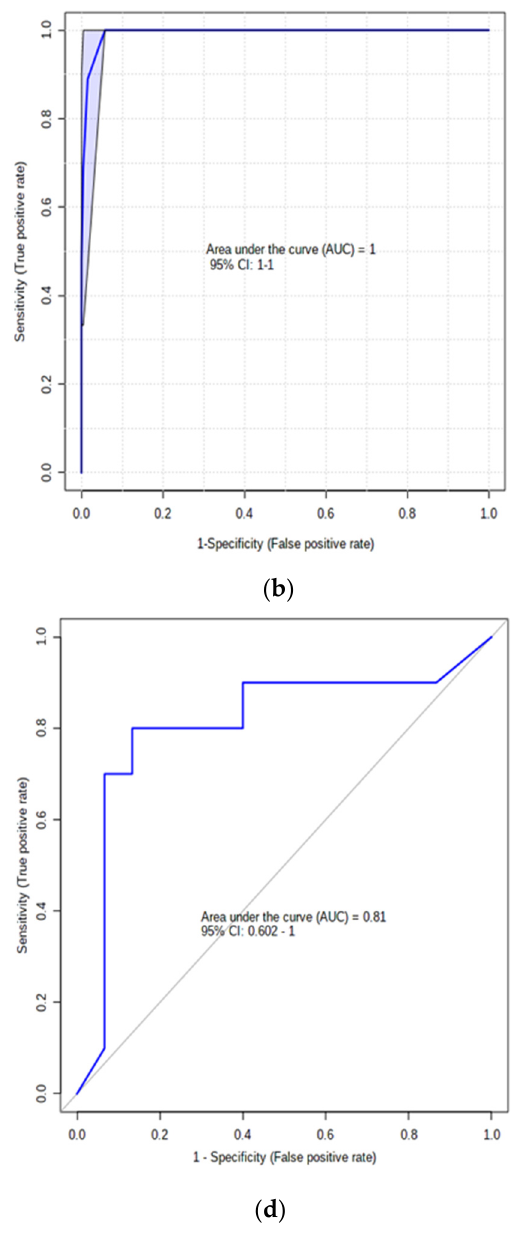
Figure 2 . ( a ) AUC of the top 5 VIP PLS-DA metabolites (PC aaC38:0, PC aa C36:0, PC ae C36:0, PC aa C40:2, PC aa C38:6) at − 8 weeks before parturition; ( b ) AUC of model’s classification; ( c ) default linear SVM AUC of Leu, Betaine, Ala, and Orn (AUC = 0.92; p = 0.001) and ( d ) ROC plot with 10-fold CV for logistic regression of these 4 amino acids (AUC = 0.81; p =